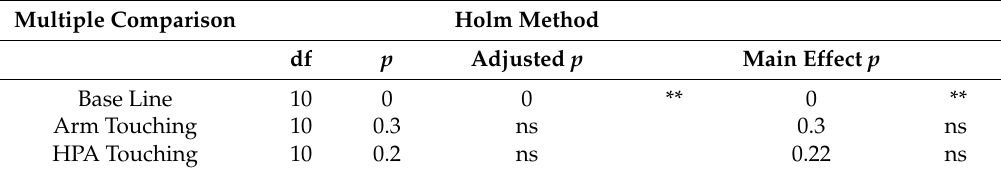
Table 3. The result of multiple comparison of S value of the healthy group. Multiple Comparison Holm Method